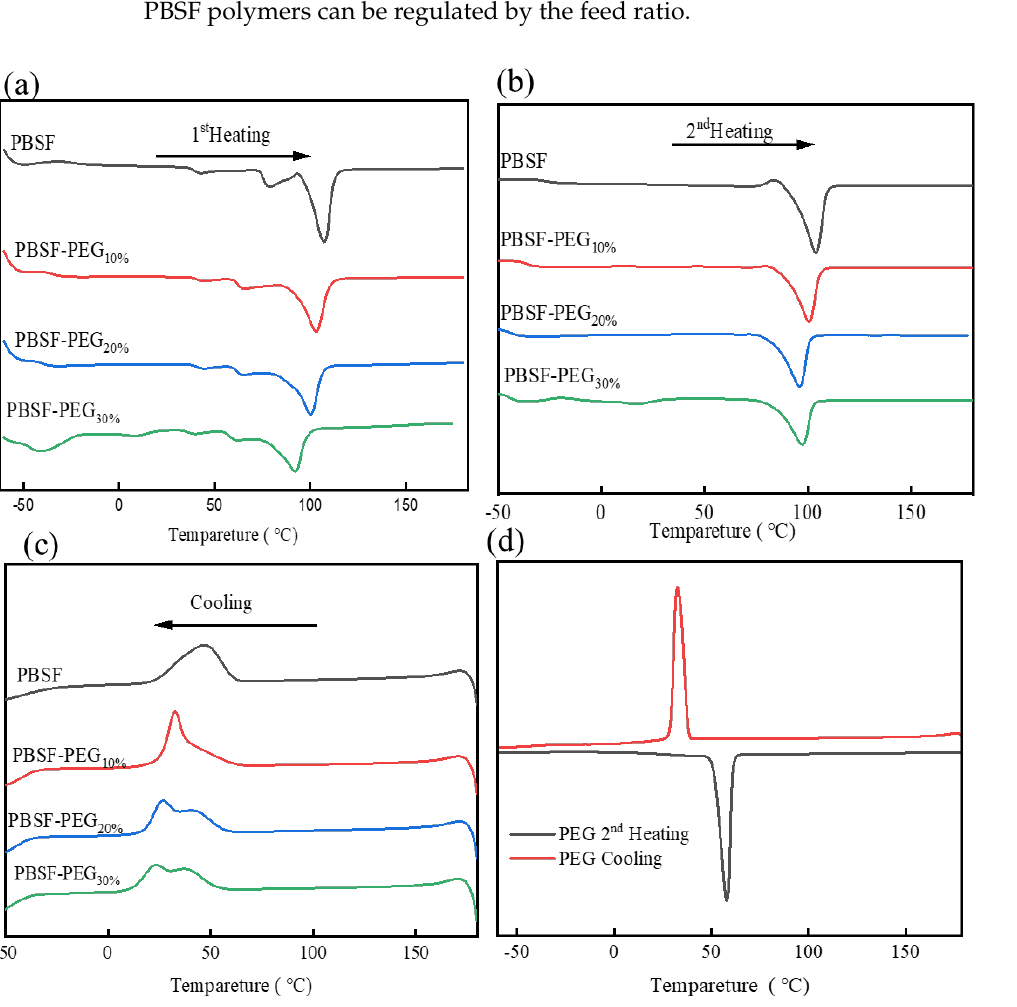
Table 2. Thermal properties of PBSF and PBSF-PEG.